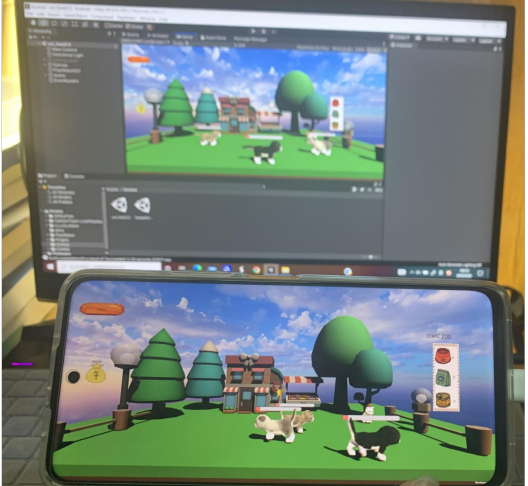
Figure 5. Simultaneous control by mobile phone and computer.